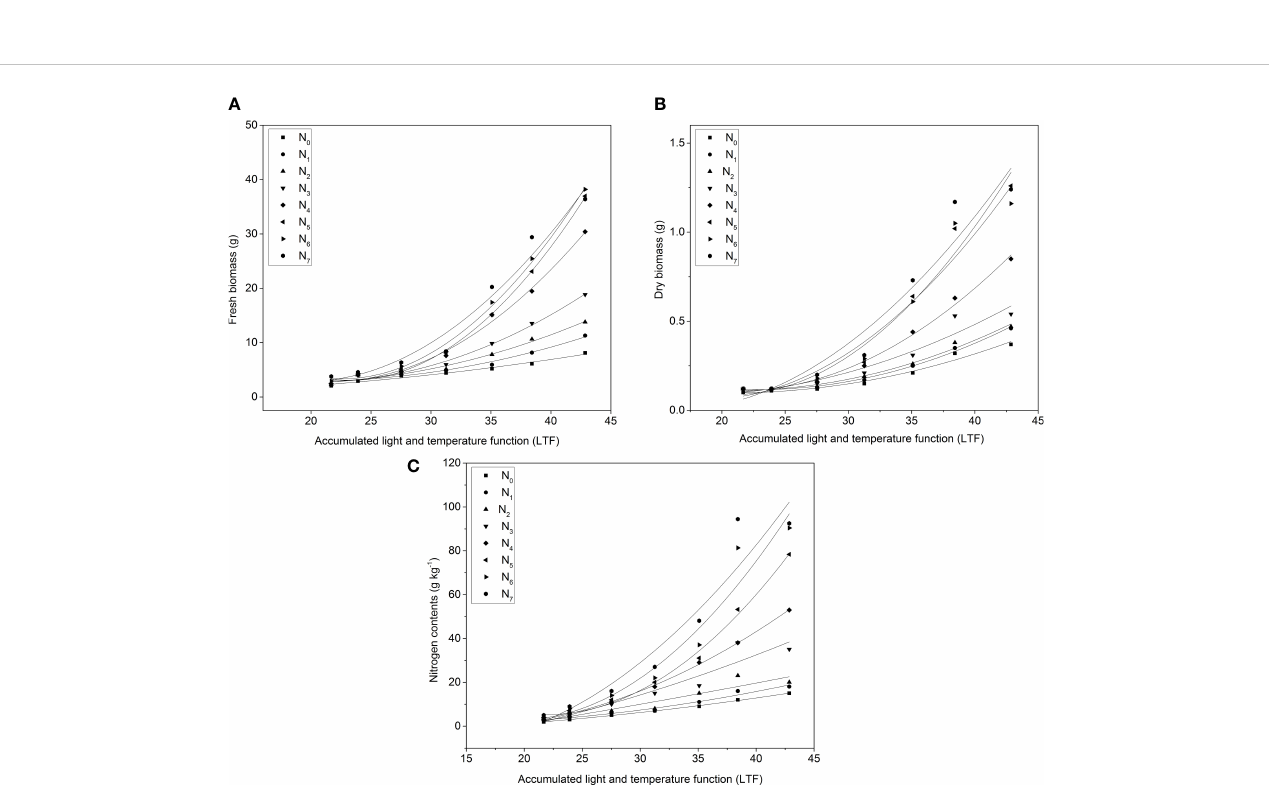
FIGURE 5 The changes of (A) FW, (B) DW, and (C) N contents with changing LTF under different N application rates. N 0 = 0, N 1 = 0.05, N 2 = 0.1, N 3 = 0.134, N 4 = 0.15, N 5 = 0.163, N 6 = 0.191, and N 7 = 0.2 g pot -1